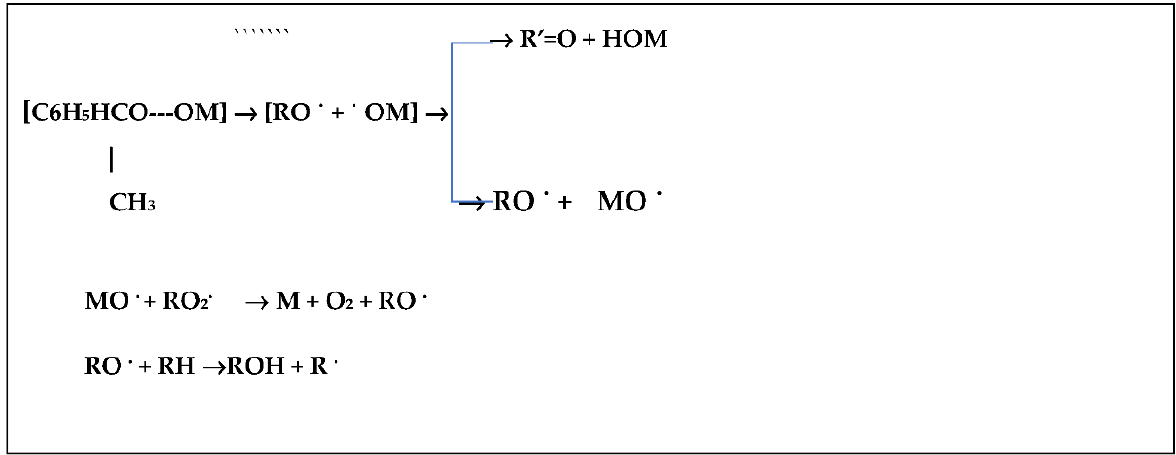
Figure 2. The ratio of the concentrations of oxidation products Δ [AP]]/ Δ [PEH] ( a ) and Δ [AP]/ Δ [MPC] ( b ) versus time t (h) in the oxidation reaction of ethylbenzene catalyzed by com- plexes {Ni(acac) 2 ∙ NaSt ∙ PhOH}, at 120 °C.